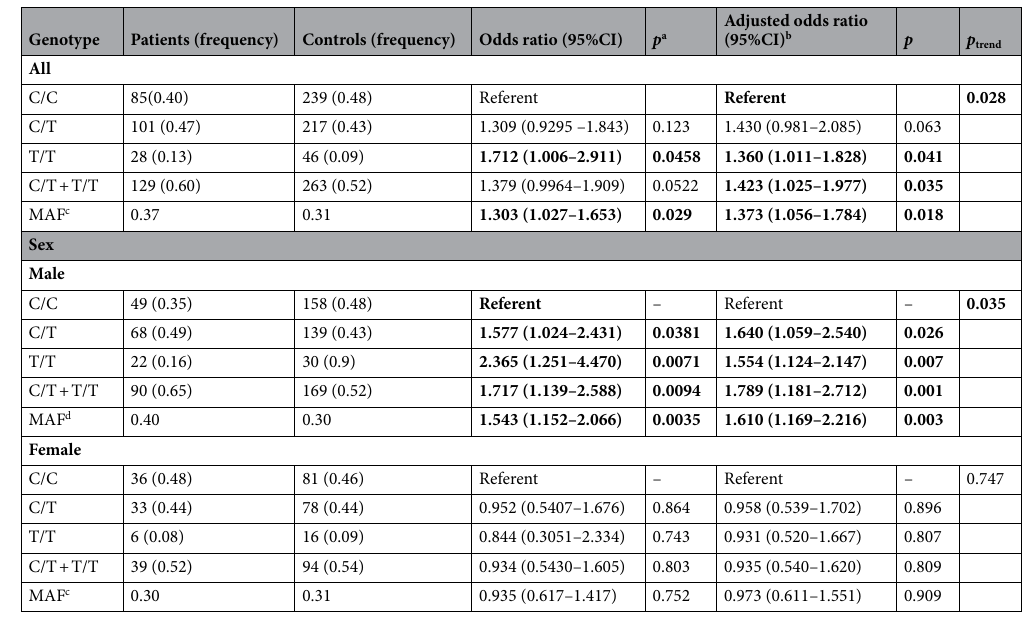
Table 2. Prevalence of the CCAT1 rs67085638 polymorphism among patients with GC and controls. Significant results are highlighted in bold font. a χ 2 . b ORs were adjusted by age, BMI and presence of diabetes. c Minor allele